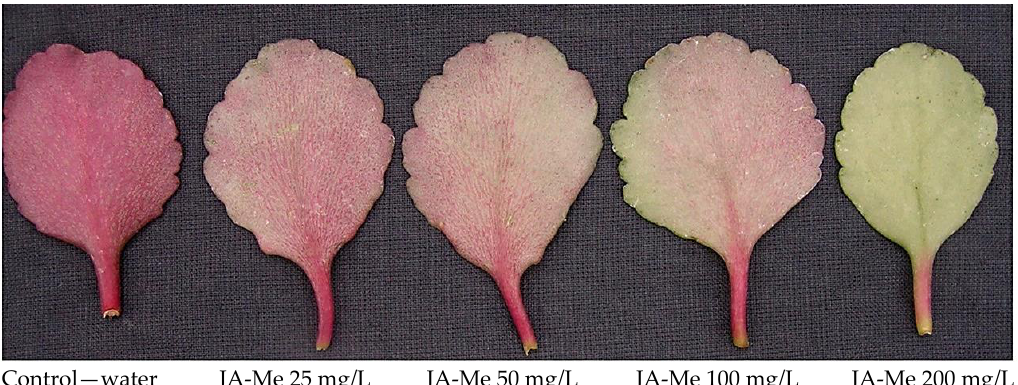
Figure 5. Effect of soaking detached K. blossfeldiana leaves in an aqueous solution of JA-Me on anthocyanin accumulation. Various concentrations of JA-Me were used, and the soaking of the leaves lasted for 1 h after which they were kept in an inverted position. In the detached stems of K. blossfeldiana, anthocyanins were formed during a few days of its storage. JA-Me at concentrations of 0.05, 0.1, and 0.5% applied as a ring in the middle of the stem inhibited anthocyanin below and above the treatment proportionally to the concentration applied (Figure 6). This indicates anthocyanin accumulation in stems is as important to JA-Me as that in detached leaves. Figure 6. Effect of JA-Me in lanolin on anthocyanin accumulation in excised stems of K. blossfeldiana . JA-Me was applied as a lanolin paste, then the treated stem segments were kept in natural light conditions. Pictures were taken 4 days after treatment. Initial Control JA-Me 0.05% JA-Me 0.1% JA-Me 0.5% Without lanolin